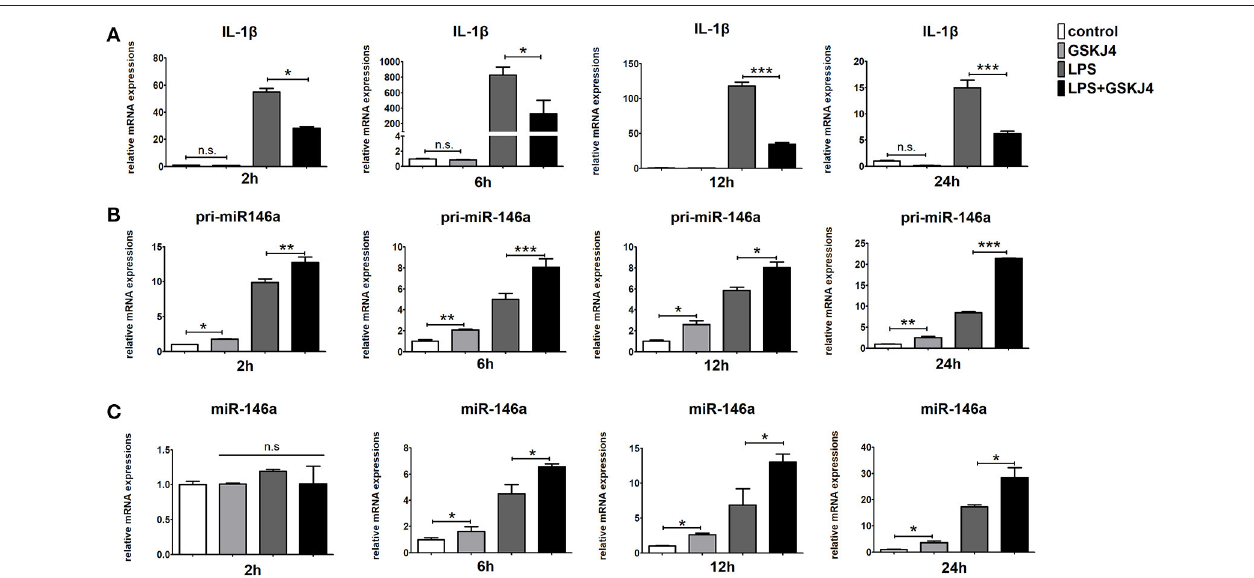
FIGURE 4 | GSKJ4 amplifies miR-146a expression under LPS-stimulation in macrophages. Raw264.7 cells were pre-treated with or without GSKJ4 (4 µ mol/L) for 1h, followed by stimulation with LPS (100ng/mL). The mRNA expression levels of IL-1 β (A) , pri-miR-146a (B), and miR-146a (C) in Raw264.7 were determined by quantitative PCR at different time. Data are shown as mean ± SEM ( n = 3). * P < 0.05; ** P < 0.01; *** P < 0.001.